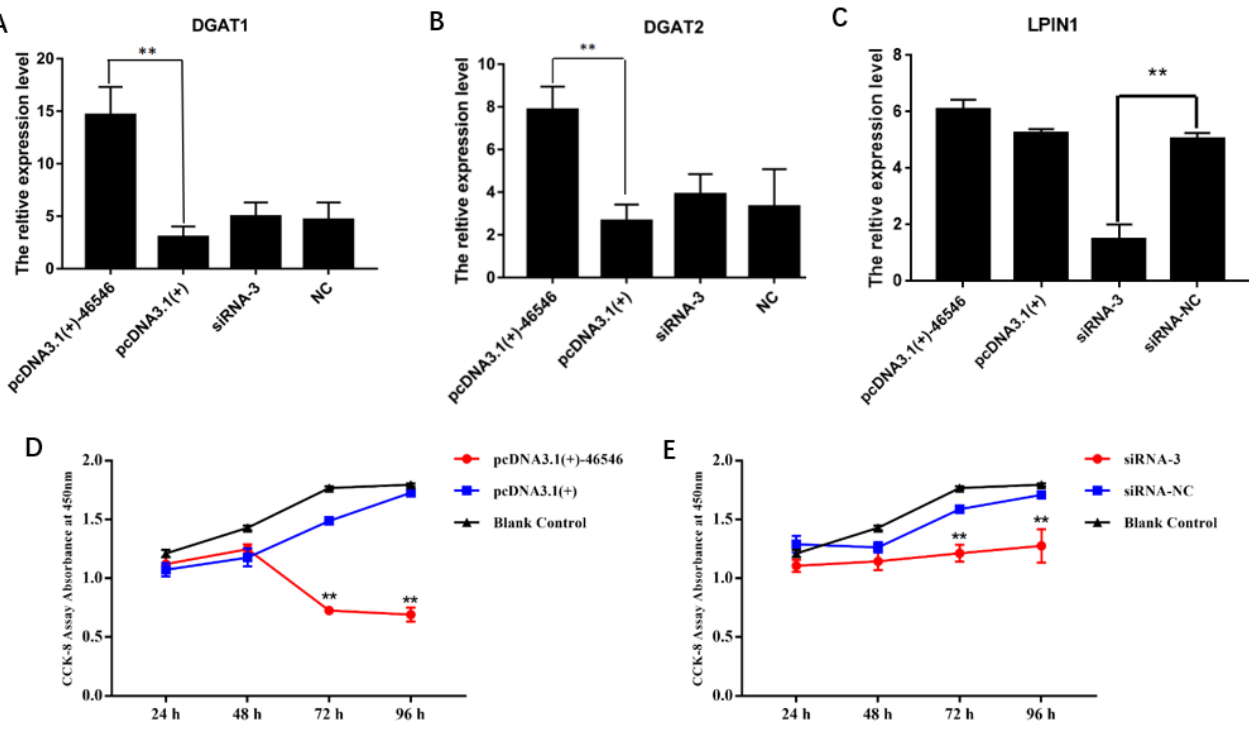
Figure 8. (A) to (C) lncRNA-46546 promoted the expression of the DGAT1 , DGAT2 , and LPIN1 genes. ** Denotes p<0.01. (D) lncRNA-46546 signifi - cantly inhibited the proliferation of ICP2 cells. (E) Knockdown of lncRNA-46546 had a weaker effect on the proliferation of ICP2 cells. ** Denotes p<0.01. * Denotes p<0.05. DGAT1 , diacylglycerol acyltransferase 1; DGAT2 , diacylglycerol acyltransferase 2; LPIN1 , lipid phosphate phosphohydro- lase 1; ICP2, immortalized chicken preadipocyte